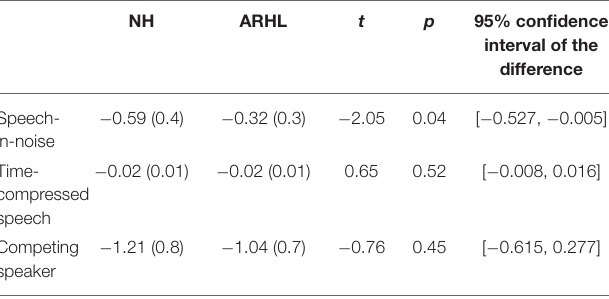
TABLE 3 | Means and (SDs) of the individual linear learning slopes for trained normal-hearing (NH) and trained Age-related hearing loss (ARHL)